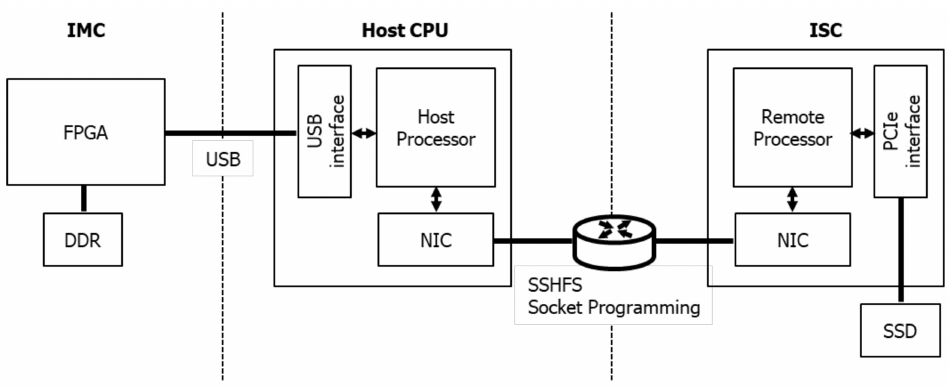
Figure 3. Integrated solution of in-memory and in-storage computing architecture proof of